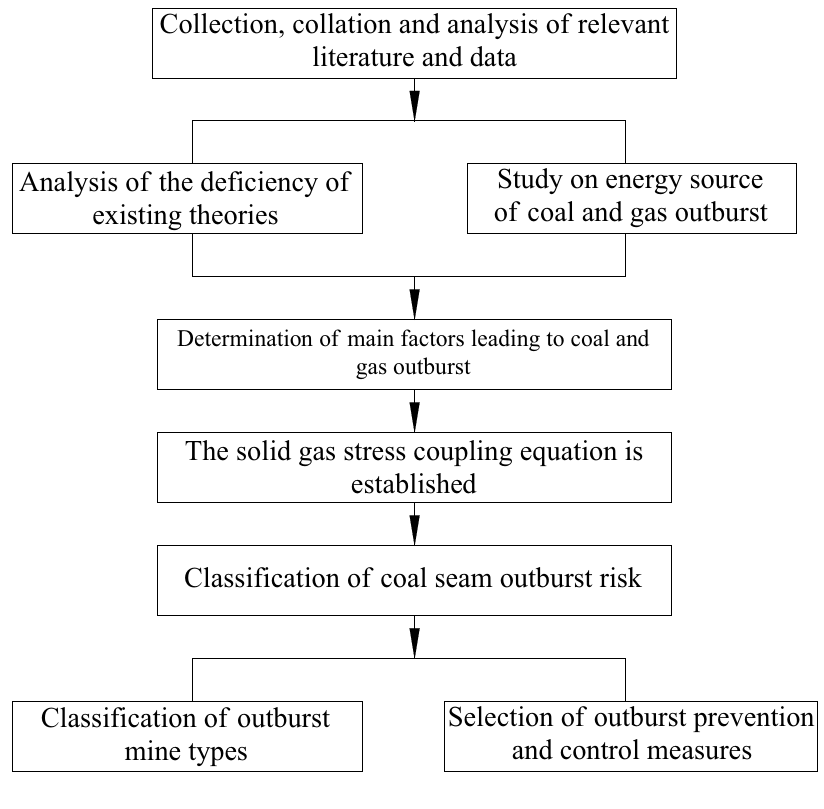
Figure 1. Flowchart of this